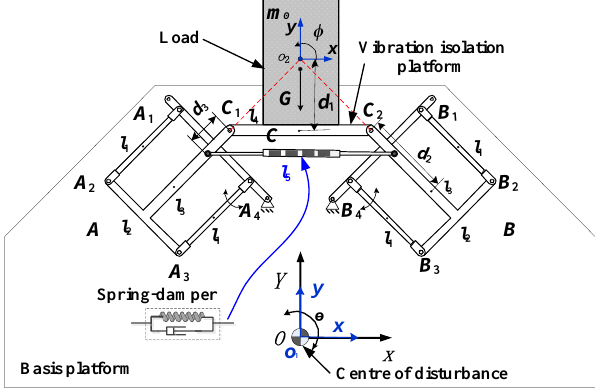
Figure 1. Mechanistic diagram of the vibration isolator.